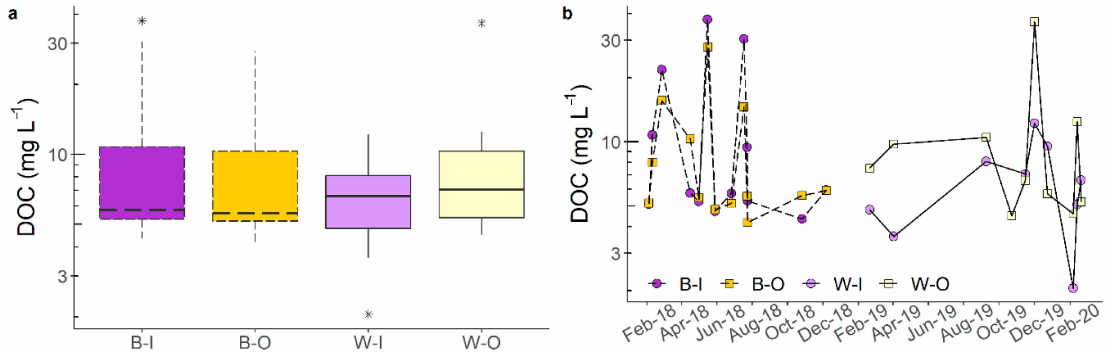
Figure 7. Boxplots ( a ) and line plots ( b ) of flow weighted concentrations of dissolved organic carbon (DOC) at the inlet (I) and outlet (O) of the dry basin (B) and wetland (W). Statistical outliers represented by